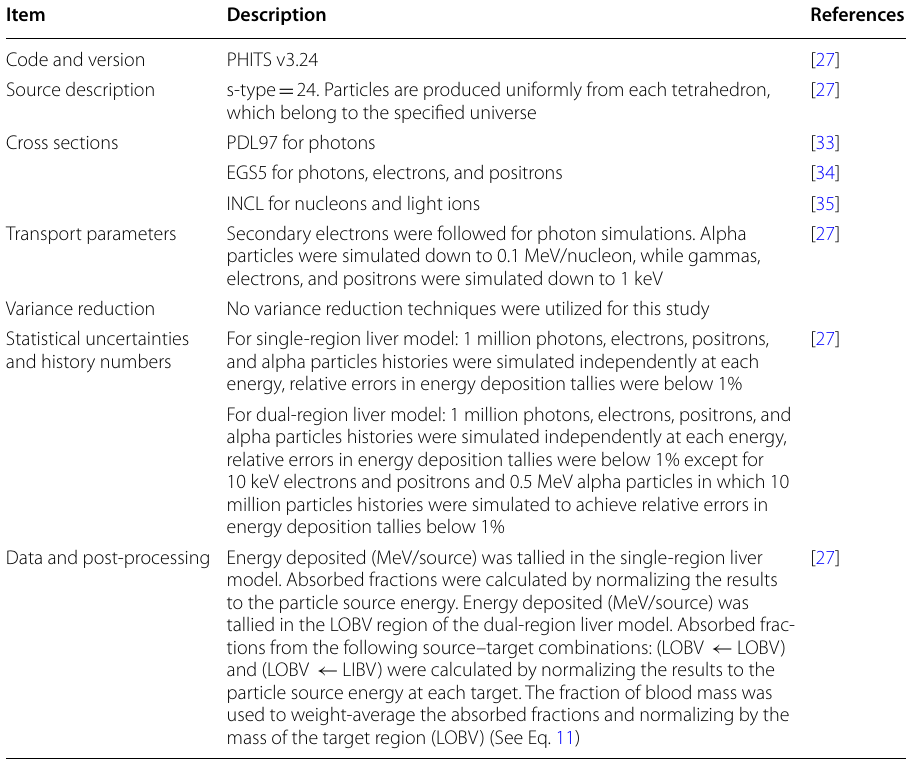
Table 2 Details of the PHITS transport computations and data post‑processing